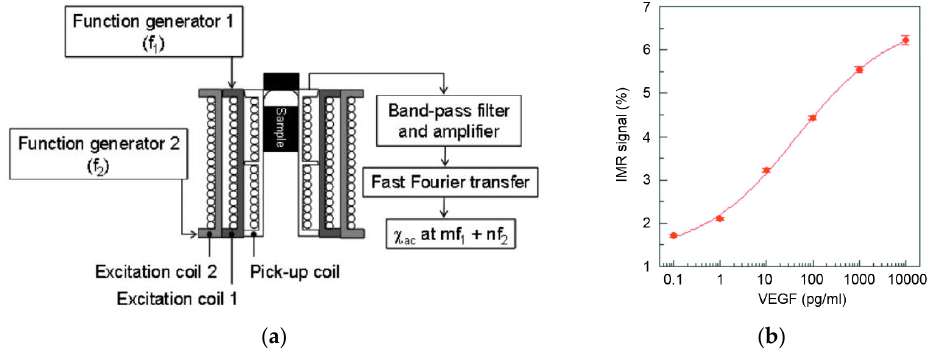
Figure 5. Schematic experimental setup and assay results of the mixed-frequency AC susceptibility measurement technique: ( a ) Measurement setup comprising two excitation coils and a pick-up coil for signal generation [150]. The AC susceptibility signal χ AC at mixed frequency is determined by applying read-out electronics comprising band-pass filters, a signal amplifier and Fourier transformation. Graph reprinted with permission from Hong et al. , [150]. Copyright (2007), AIP Publishing LLC; ( b ) Assay results and corresponding fit by the logistic function for the vascular endothelial growth factor (VEGF) protein as reported by Chieh et al. [152]. Modified graph reprinted